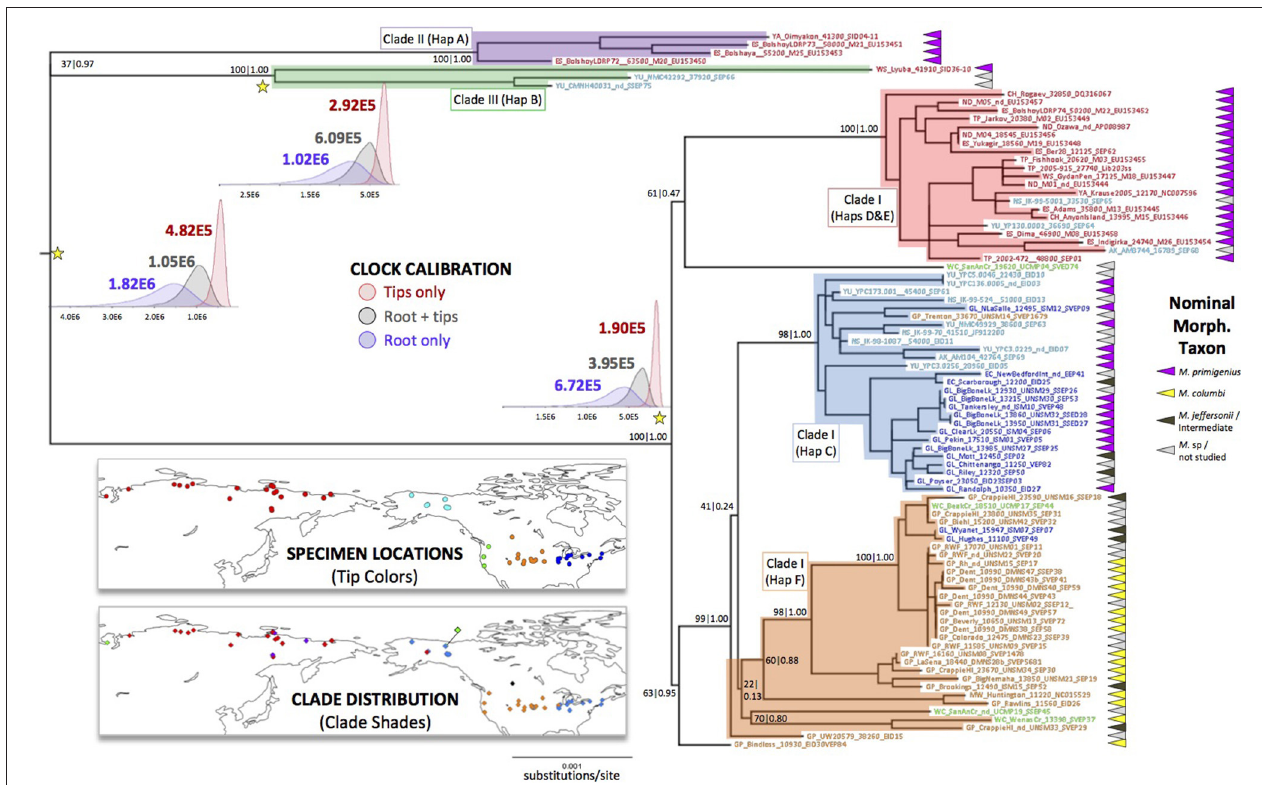
FIGURE 2 | Maximum Likelihood tree with spatial distribution of samples and clades, and posterior distributions of estimated times to most recent common ancestry for three nodes. Tree generated with a 100-bootstrap analysis in IQ-TREE using the nucleotide substitution model, alpha, and invariant site proportion parameters chosen by the corrected Akaike Information Criterion (AICc) in jModelTest. A mitogenome sequence of Elephas maximus (Asian elephant) was used as an outgroup, but is removed from this depiction. Nodal support was further assessed with a Bayesian coalescent approach in BEAST. Bootstrap and posterior probability support are depicted as (bootstrap)|(posterior). Tip names follow those in Supplemental Table 1A and are color-coded by location, as depicted on the upper map. Clades discussed in the text are shaded by color, and their distribution is depicted on the lower map. Posterior distributions of times to most recent common ancestry (tMRCA) estimated under three different temporal calibration schemes are depicted near the nodes marked with yellow stars. Mean tMRCA estimates label each